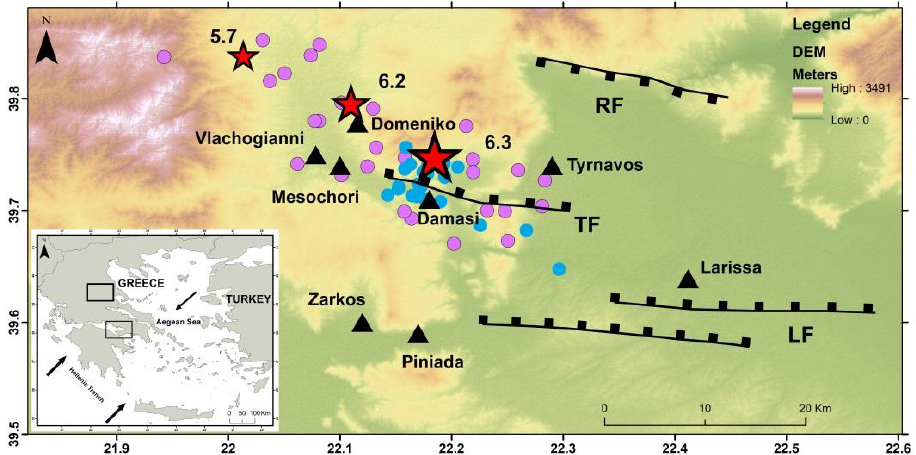
Figure 1. The Thessaly area, Central Greece, that ruptured by three strong earthquakes on 3, 4 and 12 March 2021 with magnitudes, M w , of 6.3, 6.2 and 5.7, respectively, as determined in this study; stars show strong earthquake epicenters relocated in the present study. Blue and purple colored circles illustrate foreshocks and aftershocks occurring from 28 February to 3 March and from 3 to 15 March, respectively (epicentral determinations by NOA, http://www.gein.noa.gr/en/seismicity/earthquake-catalogs, last access 25 May 2021). Black lines and black triangles show the main normal faults in the area [2–8] and settlements reported in the main text, respectively; fault name codes: LF = Larissa Fault, TF = Tyrnavos Fault, RF = Rodia Fault. In the inset map, arrows illustrate directions of main lithospheric motions; thick and thin rectangles show the study area and the east Corinth Gulf area, respectively, the last one discussed in the main text.